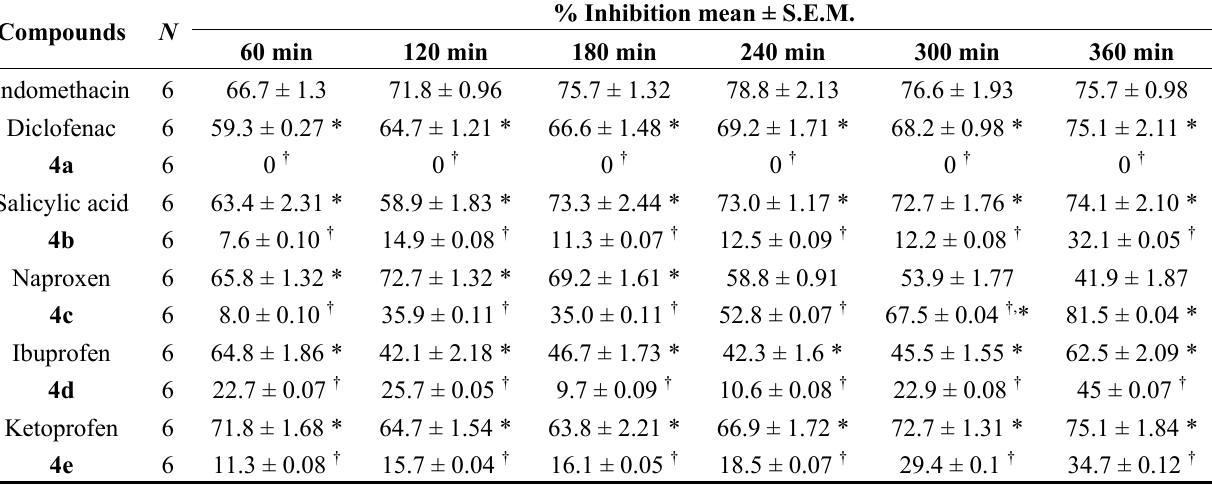
Table 1. Effect of N- acyl hydrazone derivatives 4a – e , parental drugs (diclofenac, salicic acid, naproxen, ibuprofen, ketoprofen), and indomethacin (300 μmol/kg, p.o.) in carrageenan-induced rat paw edema